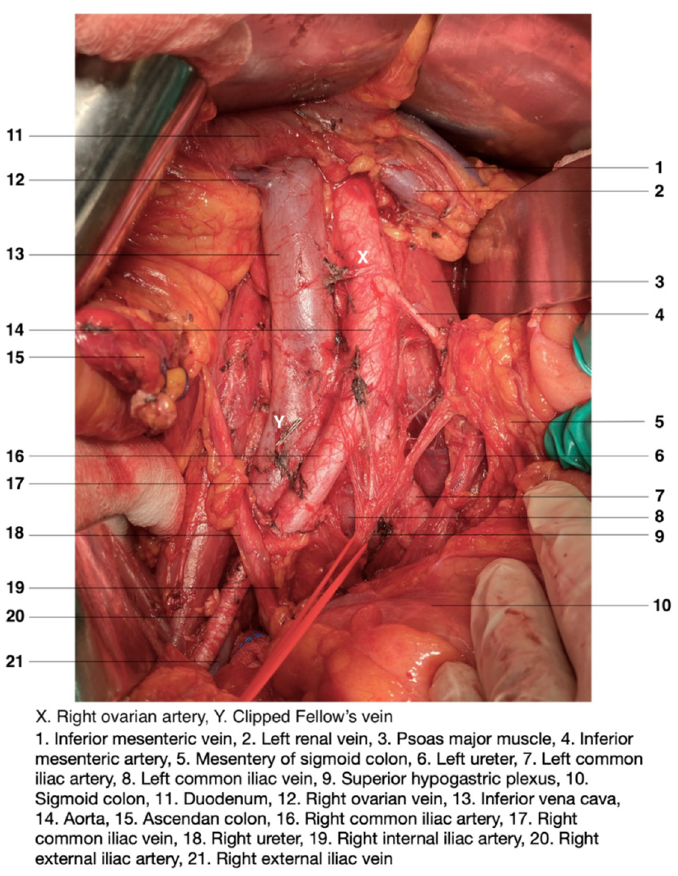
Figure 1. Topographical anatomy in the paraaortic region. An open surgery performed by doctor Ilker Selcuk.